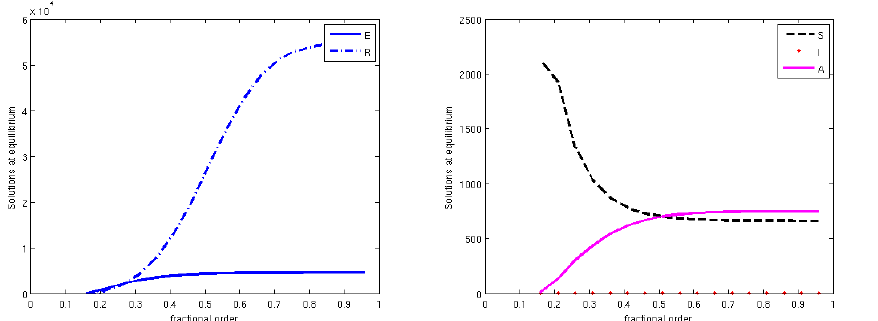
Figure 6. The model behavior for 0 < R 0 = 0.0571 < 1 as q varies in [ 0,1 ] . ( Left ) susceptibles; ( Right ) exposed, infected, asymptomatics and recovered. In this situation the system approaches the disease-free equilibrium P 0 . All the simulations have been stopped at the same final time, T = 10,000. For low values of the fractional derivative order, the populations E , I , A and R are not zero, but this feature is intentionally left in the figure. Thus, it denotes the different speeds at which the populations vanish as a function of the fractional derivative order. The parameter values are the same as those in Figure 3.